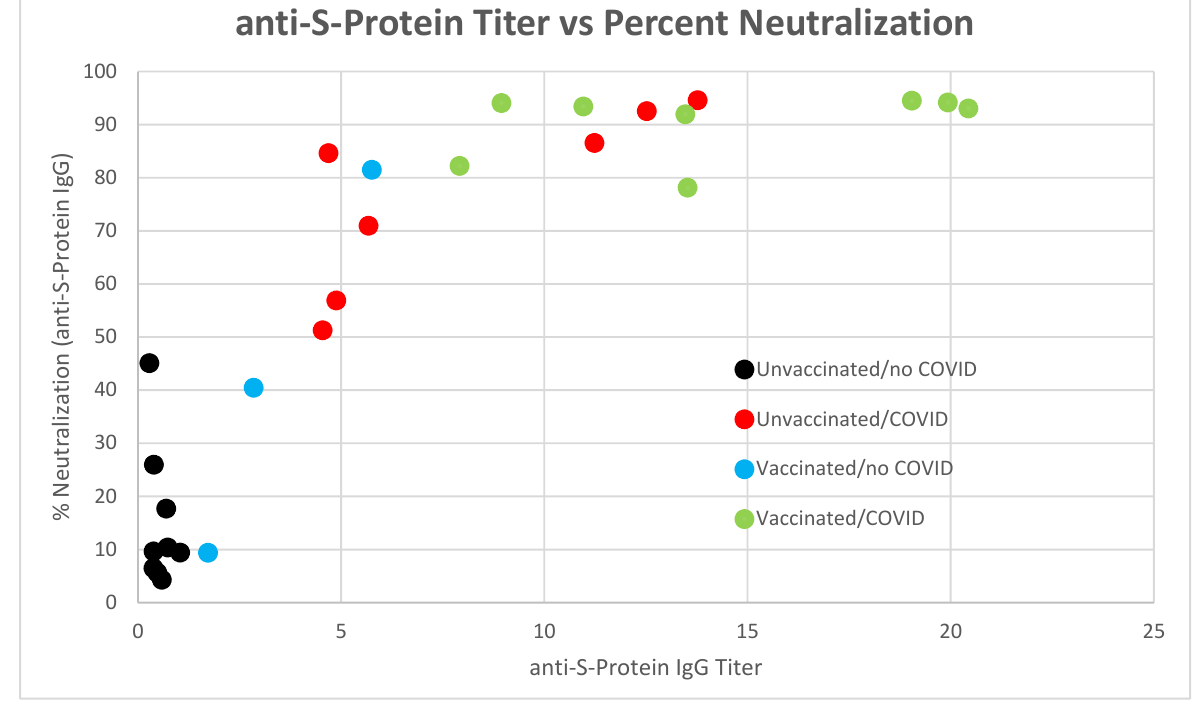
Figure 9. Correlation of SARS-CoV-2 neutralizing antibodies vs. anti-S-protein IgG titers in truCOLLECT and plasma samples amongst different donor groups: unvaccinated/no-COVID, unvaccinated/COVID, vaccinated/no-COVID and vaccinated/COVID.